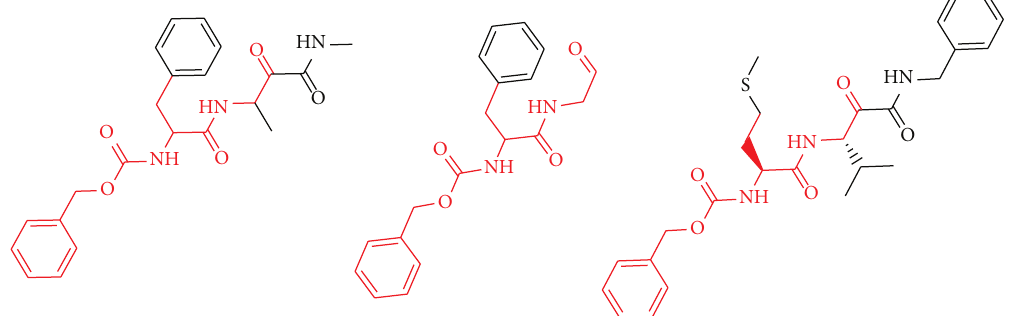
Figure 2: An example of MCS. The MCS of the three structures is depicted in